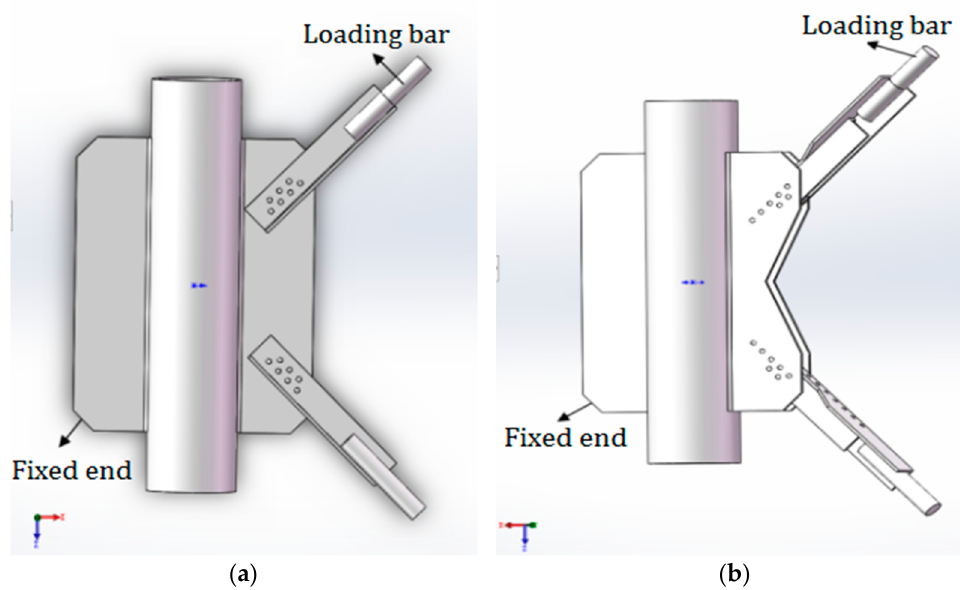
Figure 5. ( a ) Finite element model of PSLSPJ; ( b ) finite element model of PDLDPJ.